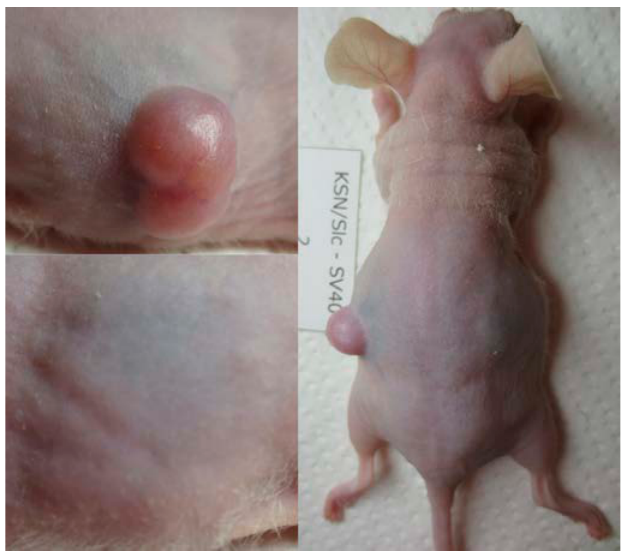
Figure 3 Subcutaneously transplanted normal hepatocytes after FACS (NHaF) in nude mice did not form tumors within three months (left side of back), but subcutaneously transplanted cancer cells after FACS (CAaF) formed tumors (right side).